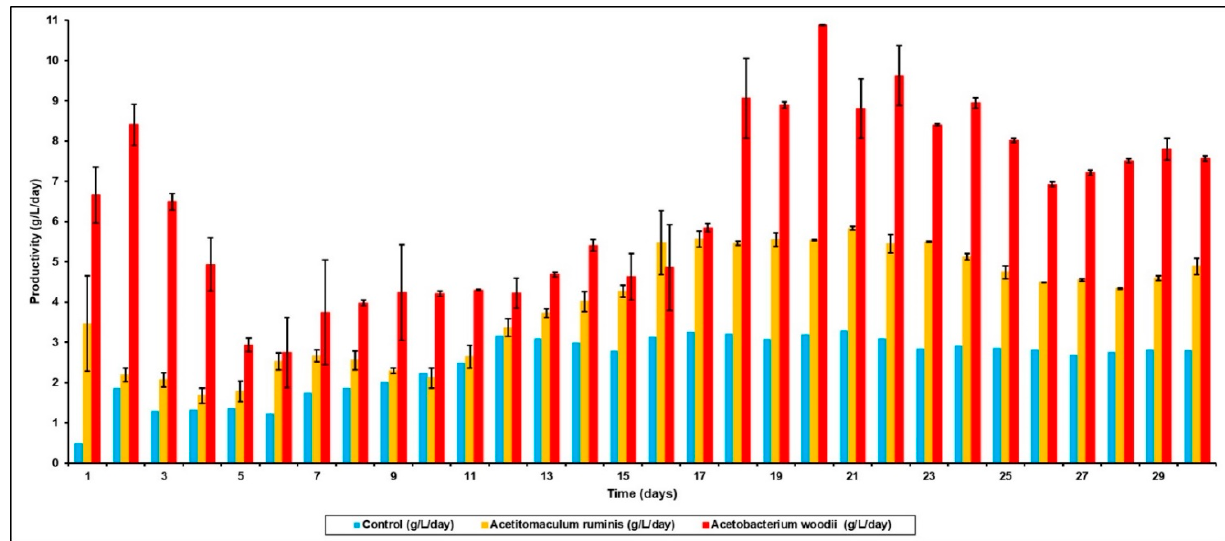
Figure 3. Total VFA productivity (g acetic acid equivalents/L/day) in control bioreactor after BES addition versus that bioaugmented with A. ruminis and A. woodii .